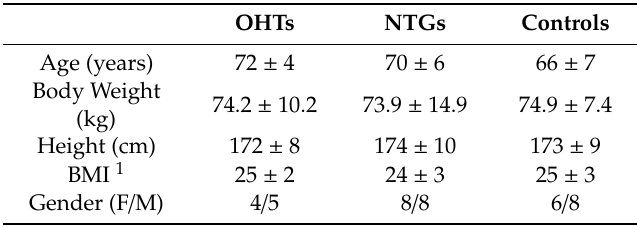
Table 1. Participant demographics.